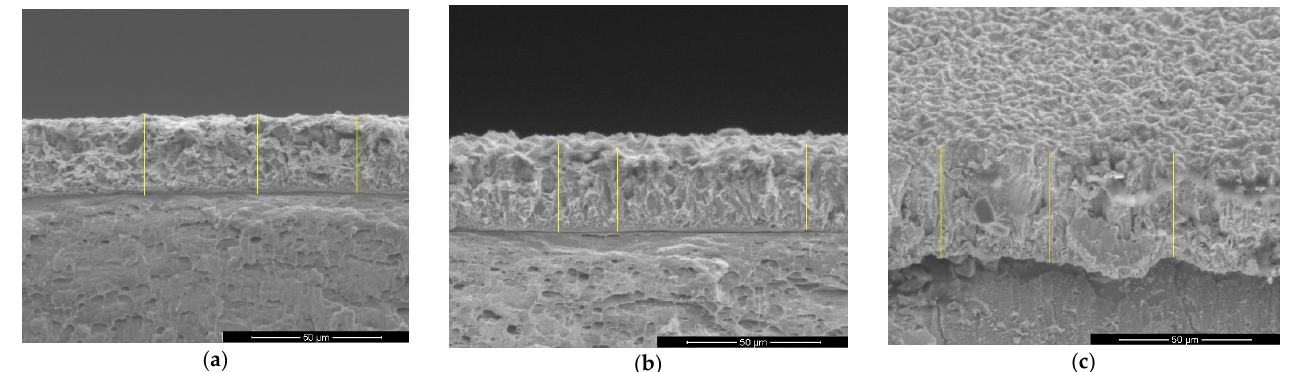
Figure 3. Cross-section images obtained with SEM showing the thickness and morphology of epoxy resin/zinc hybrid coatings: ( a ) sample A; ( b ) sample C; ( c ) sample D. Magnification: 2000×.